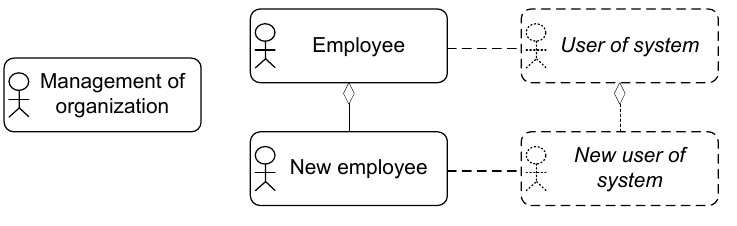
Figure 7. UAEA stakeholder and end-user model